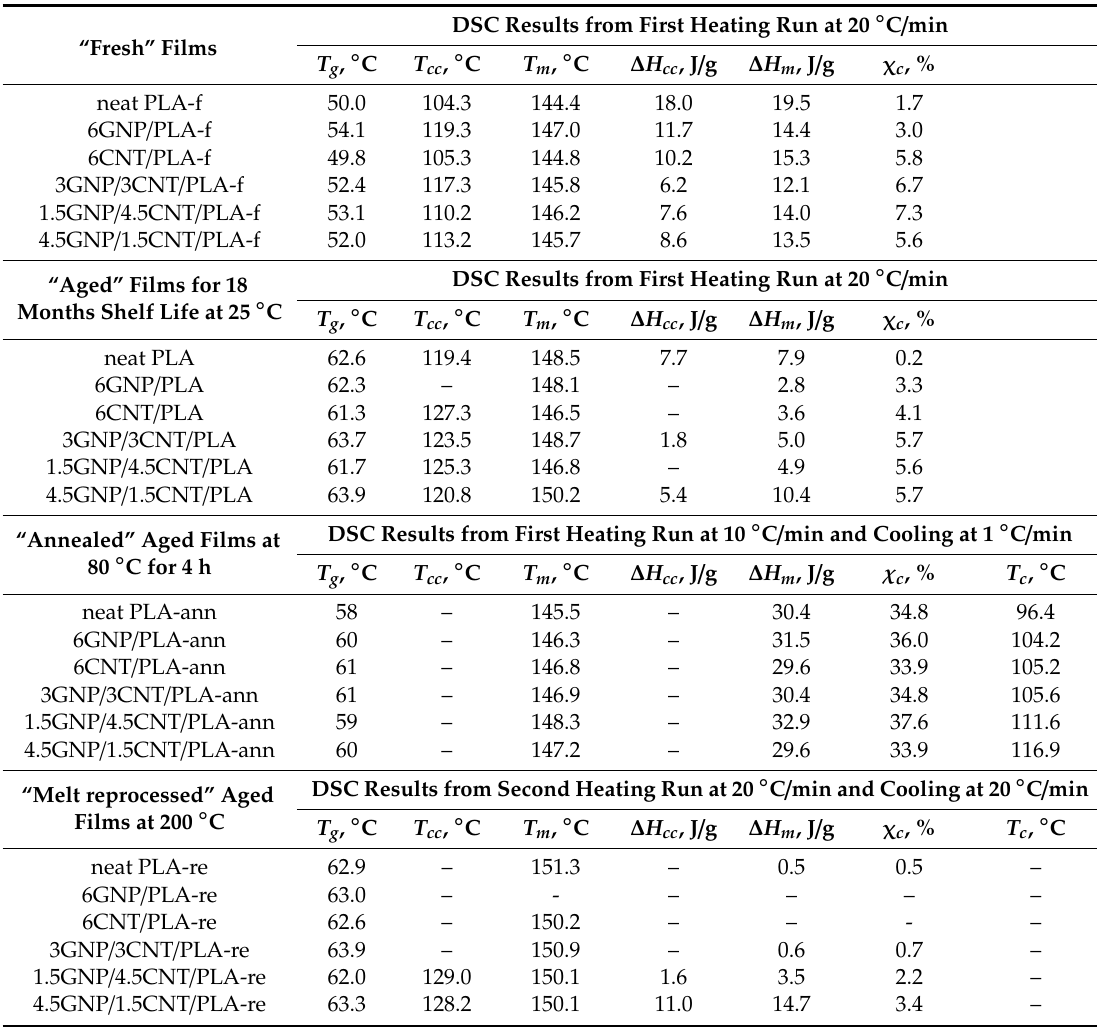
Table 1. DSC characteristic temperatures and crystallinity of fresh and aged composite films. E ff ects of solid annealing and melt reprocessing on thermal characteristics of aged